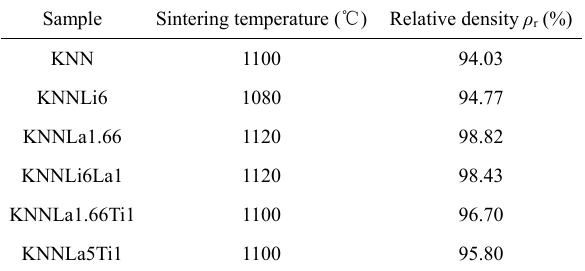
Table 1 Sintering temperatures and relative densities of the ceramic samples. The theoretical density is